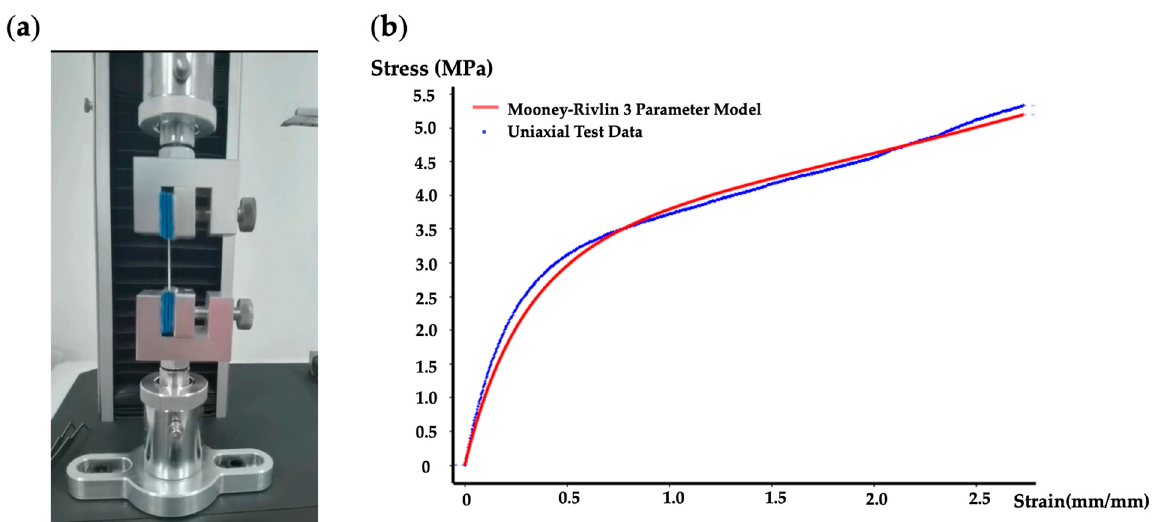
Figure 7. Characterization of hyperelastic properties of TPU materials. ( a ) Uniaxial tensile test. ( b ) Comparison between uniaxial test data and the fitted Mooney–Rivlin three-parameter model. The sum of square error method was used to determine the best hyperelastic